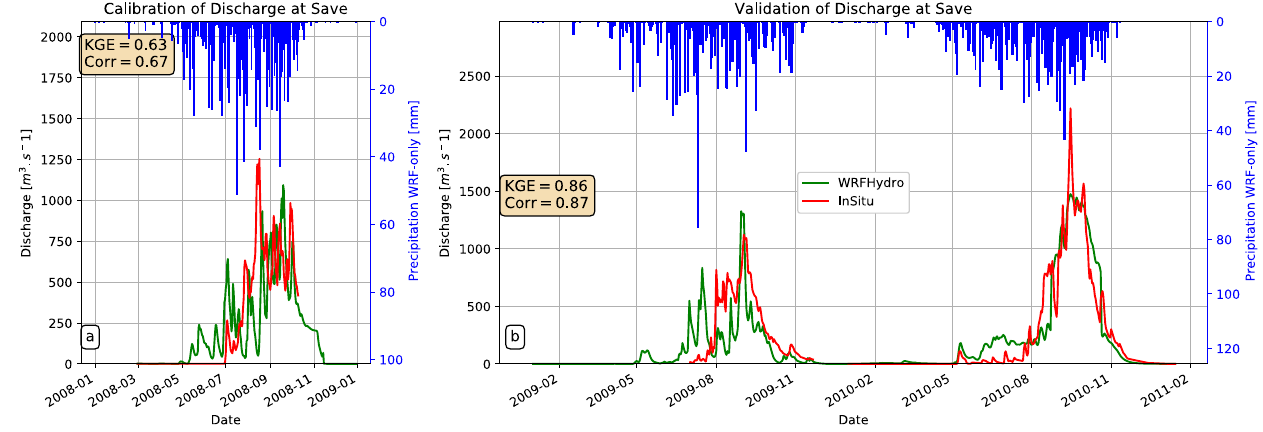
Figure 3. Observed and simulated (uncoupled WRF-Hydro) daily hydrographs at Savè, and catchment-averaged daily precipitation derived from WRF-only: ( a ) calibration period 2008; ( b ) validation period 2009–2010.